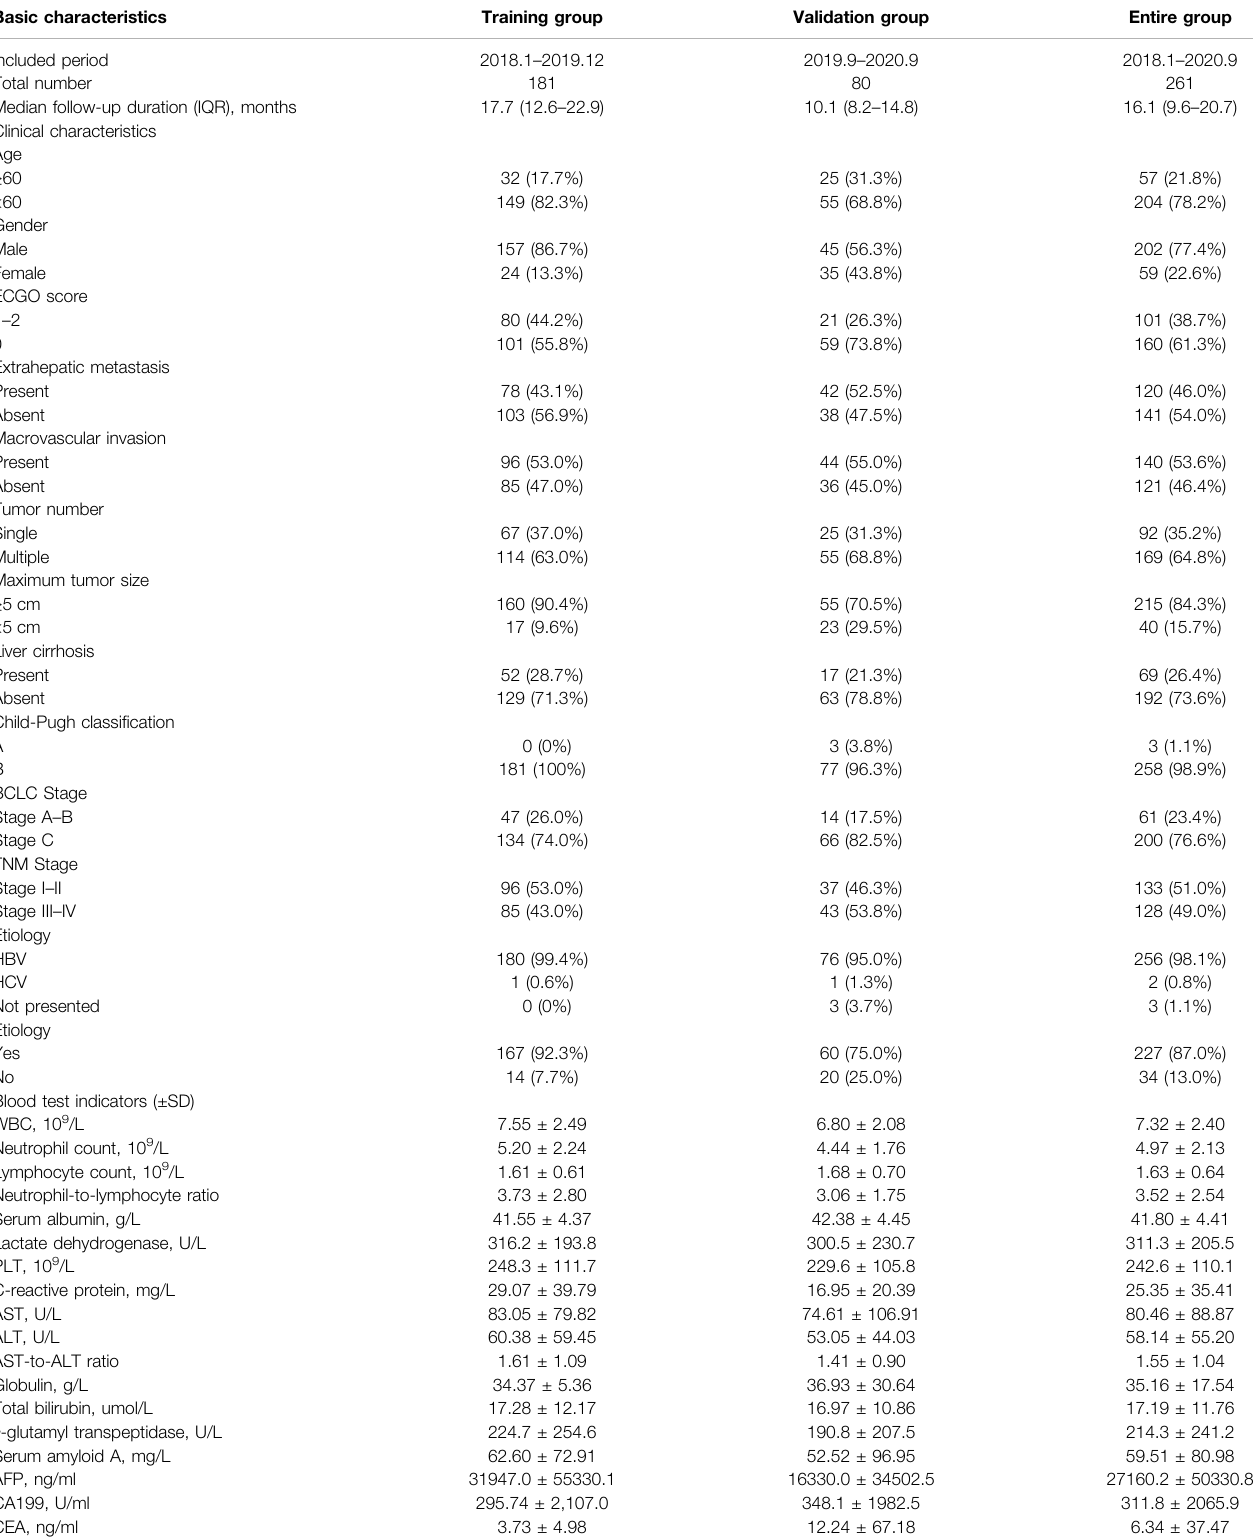
TABLE 2 | Basic characteristic of patients in the training group, validation group and entire